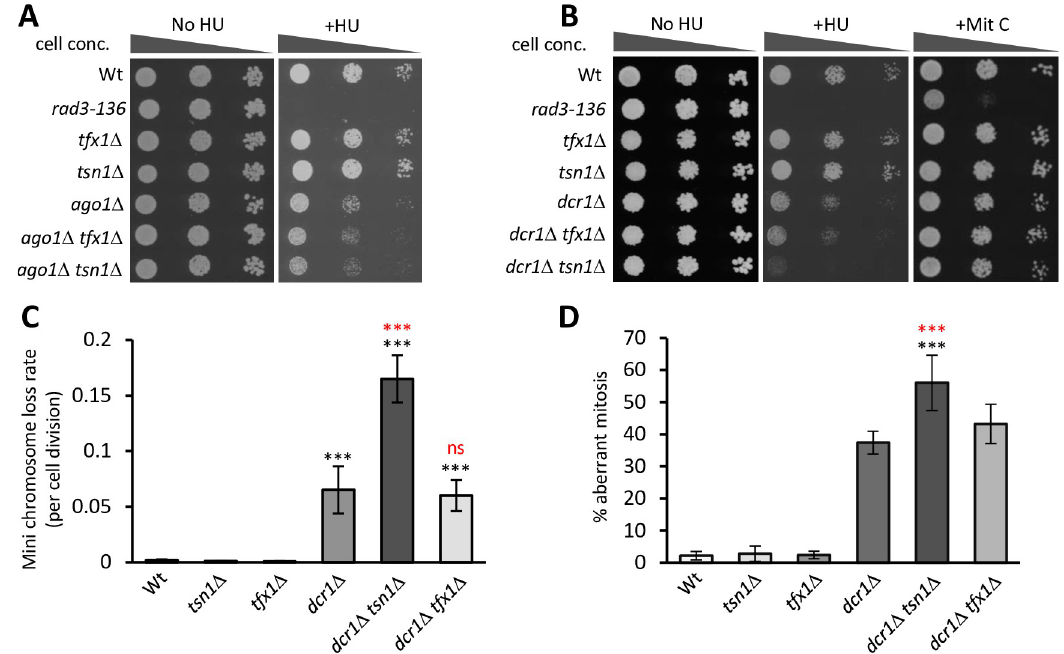
Fig 1. tsn1 + , but not tfx1 + , is required to maintain genome stability in Dcr1-deficiency, but not Ago1-deficiency. (A) Tsn1 and Tfx1 are not required for replicative stress response in Ago1-deficiency. 10-fold serial dilutions of indicated strains were spotted onto YEA with or without HU (10 mM). (B) Tsn1, but not Tfx1, function is required for some DNA replication stress responses, but not others, when Dcr1 function is lost. 10-fold serial dilutions of indicated strains were spotted onto YEA with or without HU (10 mM) or mitomycin C (150 nM). (C) Percentage of mini chromosome loss values show Tsn1 is required for chromosome stability in the absence of Dcr1. (D) Loss of Tsn1 function elevates the frequency of aberrant mitotic events in the absence of Dcr1. For C and D error bars represent standard deviation, ��� P < 0.005 (black = Student’s t -test pairwise comparison with wild-type; red = Student’s t -test pairwise comparison with dcr1 Δ mutant), ns = not significant; values are obtained from a minimum of five independent biological